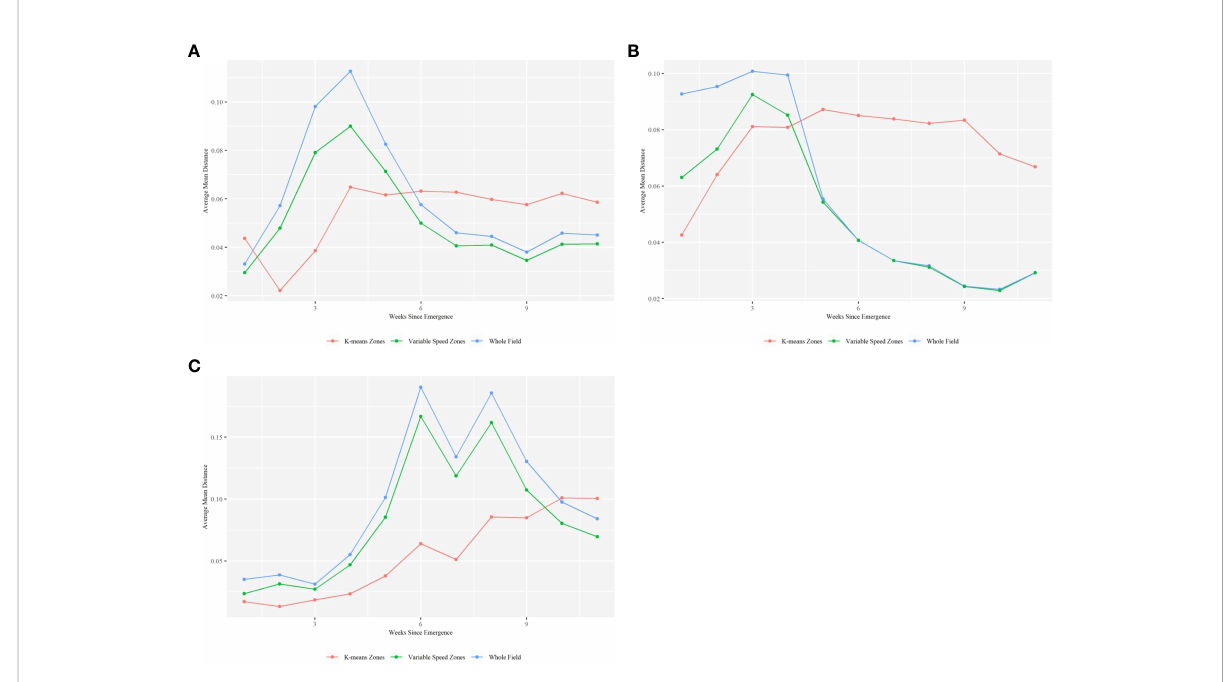
FIGURE 11 Time series of average mean distance from the zone ’ s aggregated ET value by aggregation method at (A) Field A, (B) Field B, and (C) the SWREC